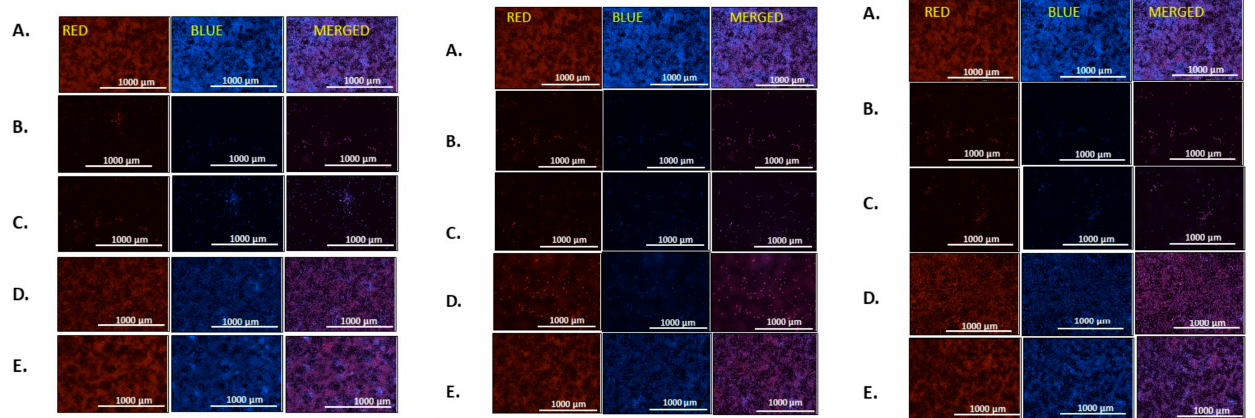
Figure 4. Analysis of apoptosis using propidium iodide (red) staining of MDA-MB-231 cells when treated with compound 2 ( left ), 8 ( center ), and 10 ( right ) at different doses, or vehicle for 48 h. Counterstain Hoersch (blue) was also used to image at 5×: ( A ) DMSO, ( B ) STS (2 μ M), ( C ) compound at 50 μ M, ( D ) compound at 25 μ M, ( E ) compound at 12 μ M. STS: Staurosporine.